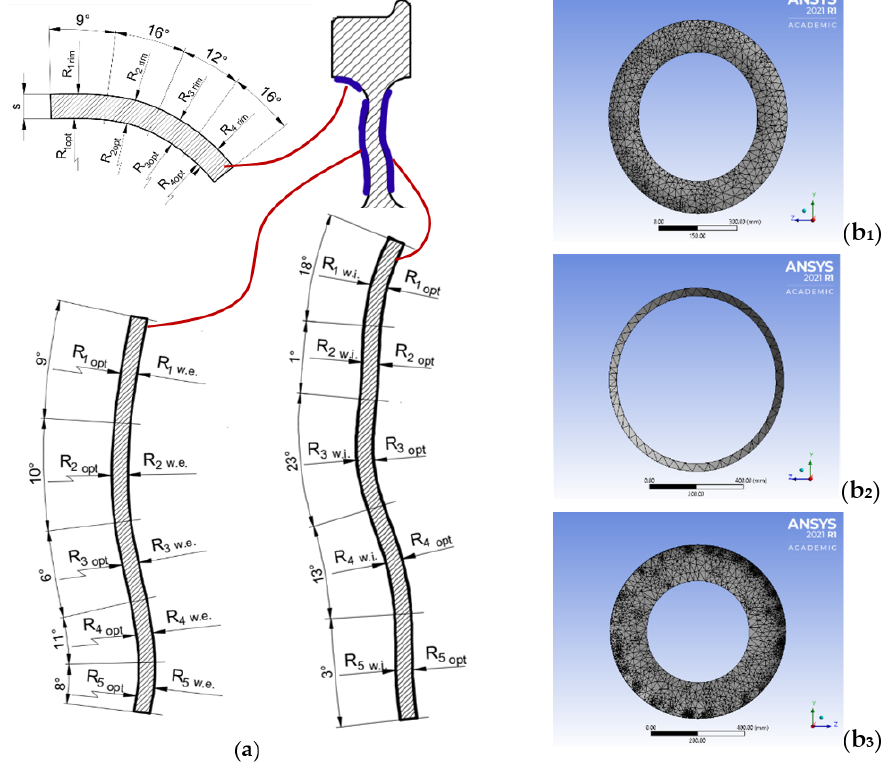
Figure 6. Viscoelastic damping layers. ( a ) Profile parametrization. ( b 1 – b 3 ) FE models.